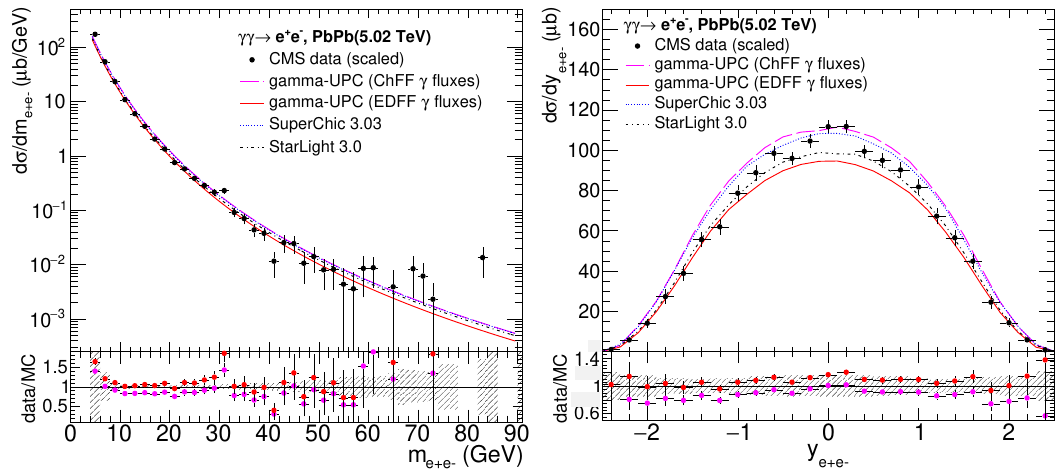
Figure 8 . Comparison of the di (cid:11) erential fiducial cross sections for exclusive e + e (cid:0) production in Pb-Pb UPCs p = 5 : 02 TeV as a function of pair invariant mass (left) and rapidity (left) predicted by gamma-UPC s at NN (EDFF and ChFF (cid:13) fluxes), S tarlight , and S uperchic . The data points show the CMS results [13] scaled as explained in the text. The bottom insets show the ratio of the CMS results (with associated systematic uncertainties indicated by hashed boxes) to the EDFF (red) and ChFF (purple) gamma-UPC predictions. Process, system